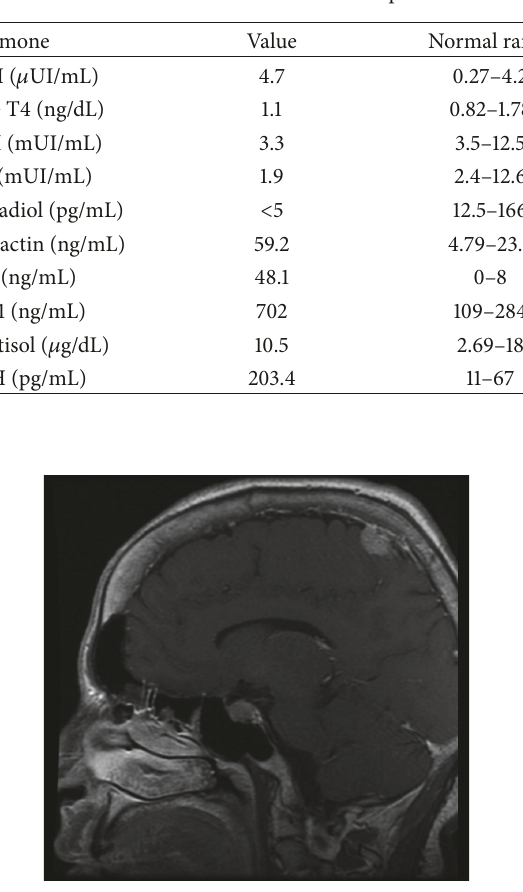
Figure 1: (NMR) pituitary macroadenoma and left superior parietal extra-axial lesion compatible with meningioma.